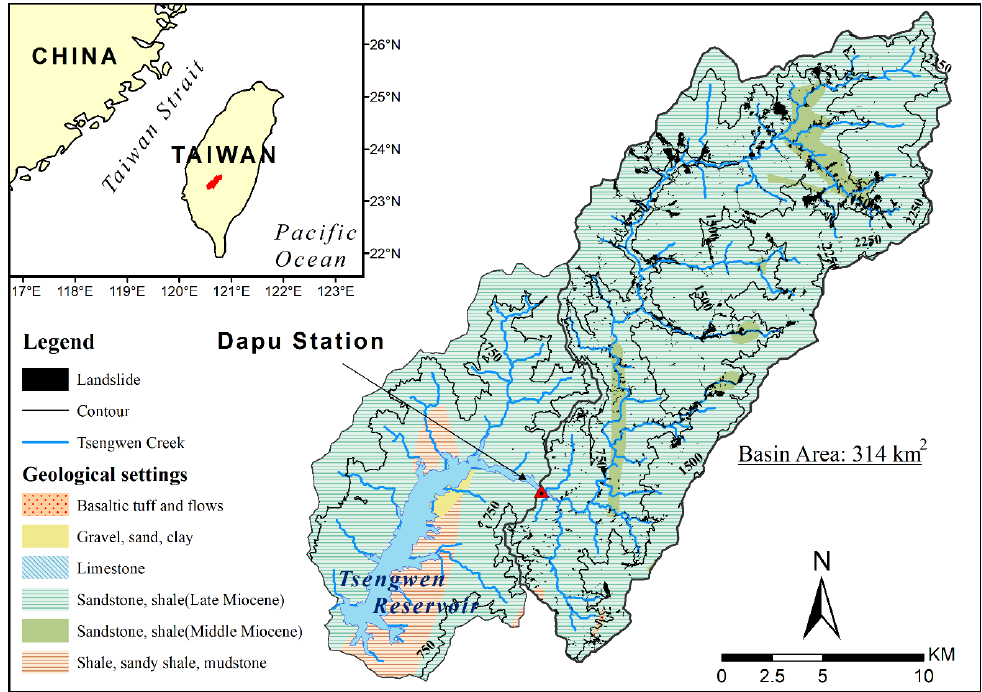
Figure 2. Geologic map of the Tsengwen Reservoir watershed.